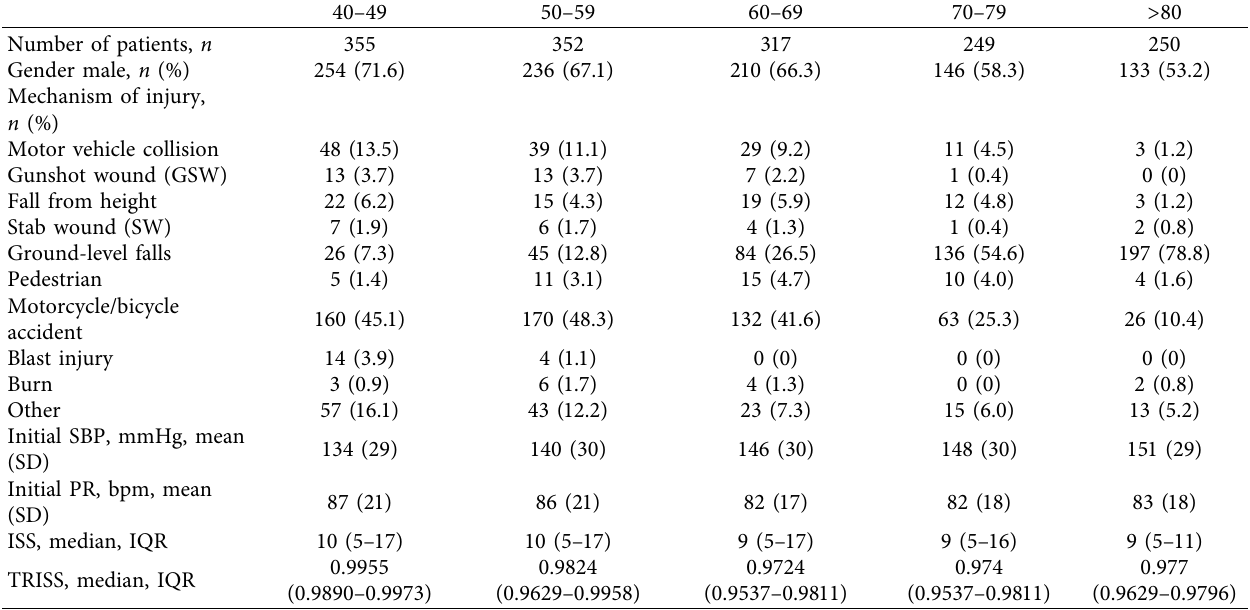
Table 3: Characteristics of patients stratified by age groups.